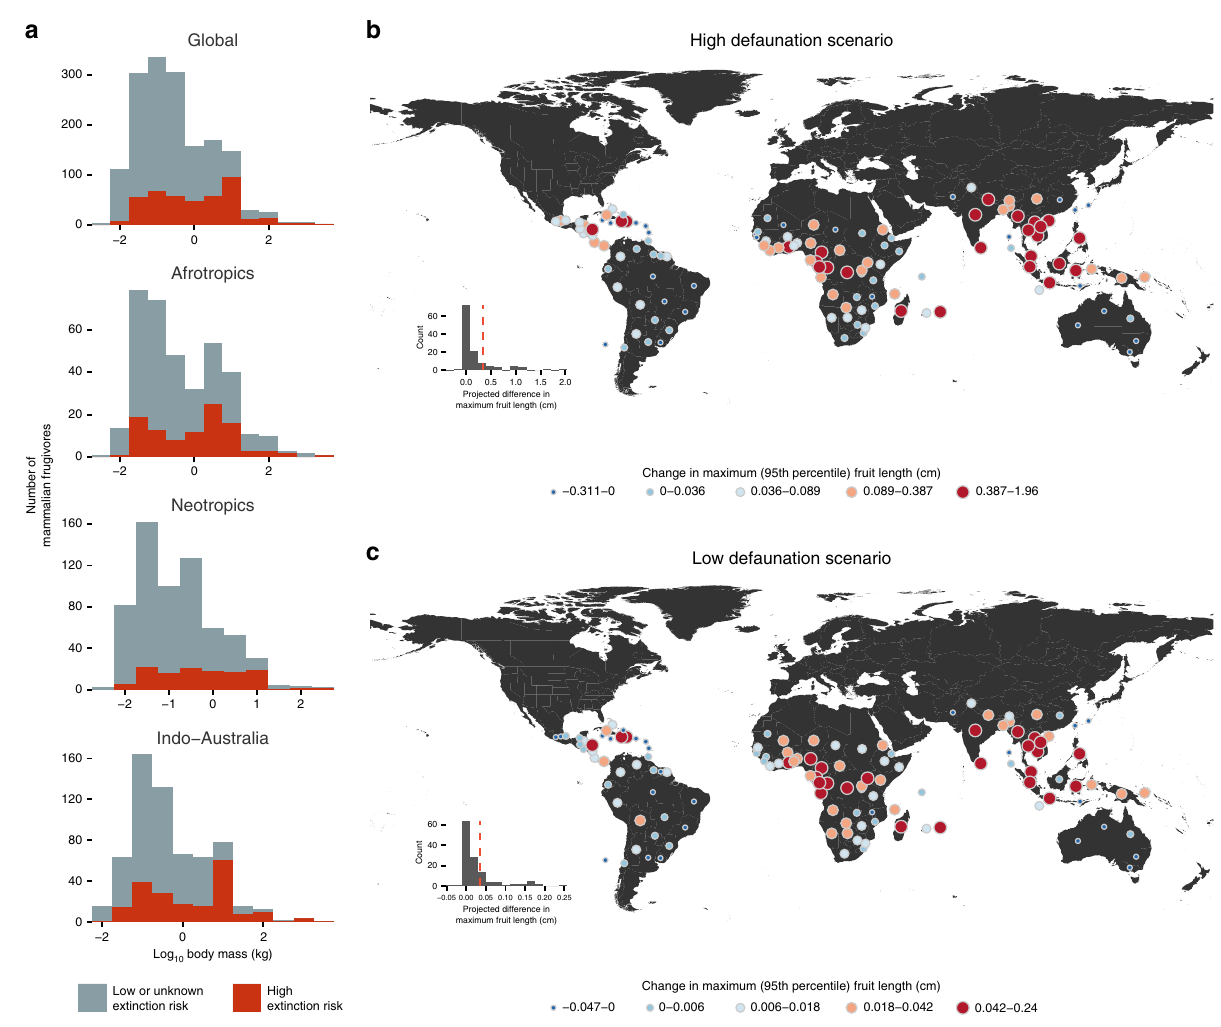
Fig. 4 The potential impact of future defaunation on palm assemblages worldwide. In a , body-size frequency distributions are shown for mammalian frugivores and colored based on IUCN Red List categories. Taxa of low or unknown extinction risk (gray) include taxa of Least Concern (LC), Near Threatened (NT) and Data De fi cient (DD) IUCN Red List status, whereas taxa of high extinction risk (red) include taxa of Vulnerable (VU), Endangered (EN), or Critically Endangered (CR) IUCN red list status. Maps b , c show the impact of defaunation on palms quanti fi ed as the projected difference in maximum fruit length between present-day frugivore body sizes and frugivore body sizes under b high and c low defaunation scenarios. Values can be interpreted as the degree of ecological and evolutionary change required for palm assemblages to maintain present-day relationships between maximum frugivore body size and maximum fruit size. Values are represented by a colored circle placed at the centroid of each botanical country, with redder colors and larger circles representing greater change toward smaller fruit size. Source data are provided as a Source Data fi